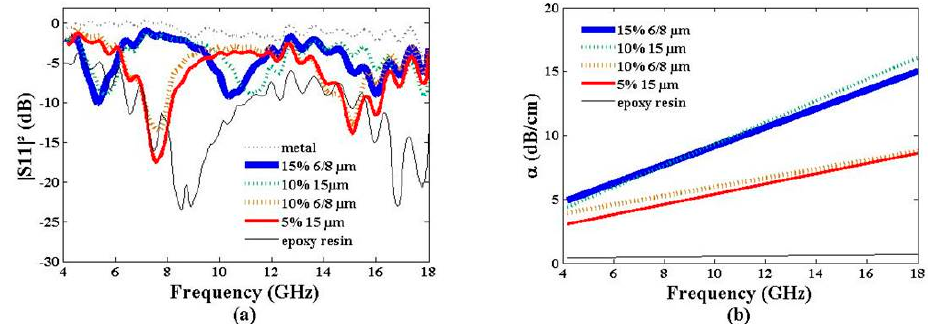
Figure 8. Reflected power |S 11 |² ( a ) and electromagnetic absorption α ( b ) vs. frequency of epoxy resin loaded with 6–8-µm and 15-µm graphene particle sizes with various weight ratios. Pristine epoxy resin values are given for reference. Table 2. Dielectric constant and loss tangent of epoxy resin loaded with 6–8-µm and 15-µm graphene particle sizes with various weight ratios.